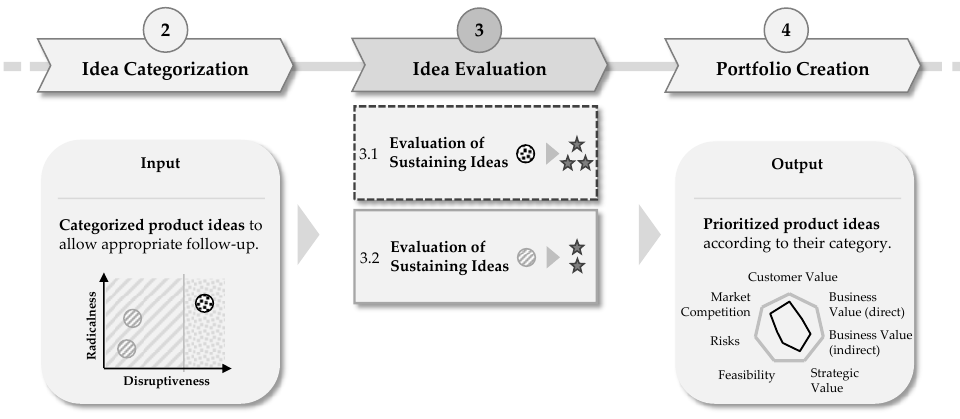
Figure 4. Idea Evaluation: Input/output and procedure.